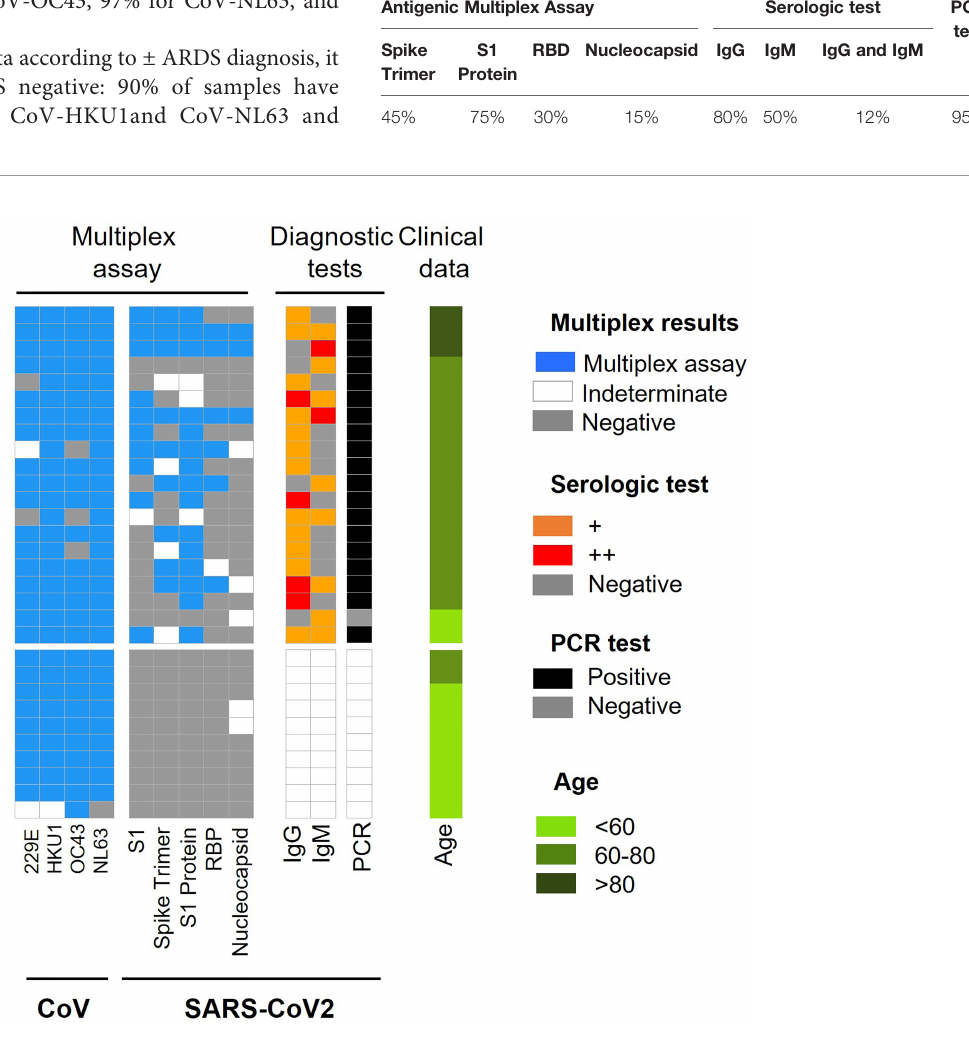
FIGURE 1 | Summary of CoV and SARS-CoV-2 antigen multiplex assay and diagnostic tests employed in ARDS cohort 1. Categorical heat map summarizing the results obtained for SARS-CoV-2 and other coronaviruses (CoV) antigen multiplex assay (blue), PCR (black) and serological diagnostic tests employed for ARDS cohort 1. The serologic test distinguishes high and very high levels of IgG and IgM antibodies (orange and red color, respectively). The samples were separated by clinical symptoms and ordered according to age (green color scale).